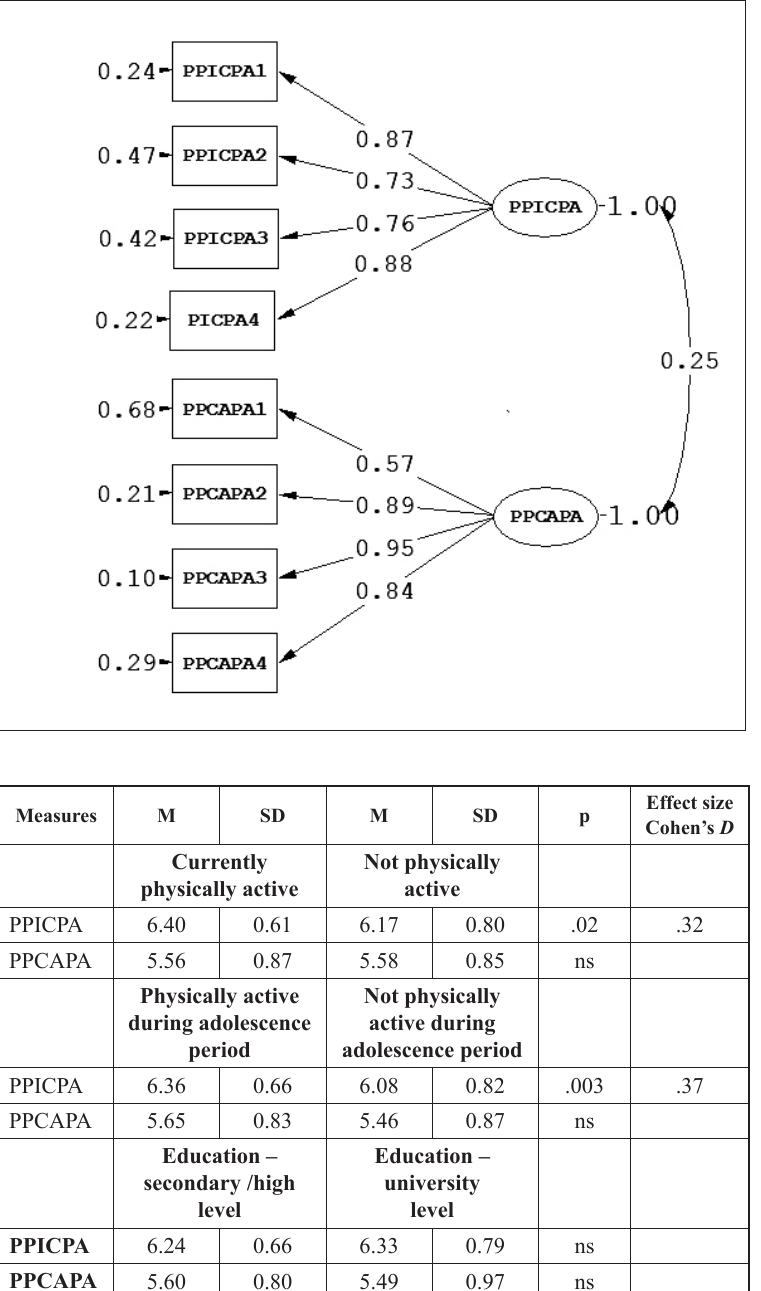
Figure. The factor structure of the question -